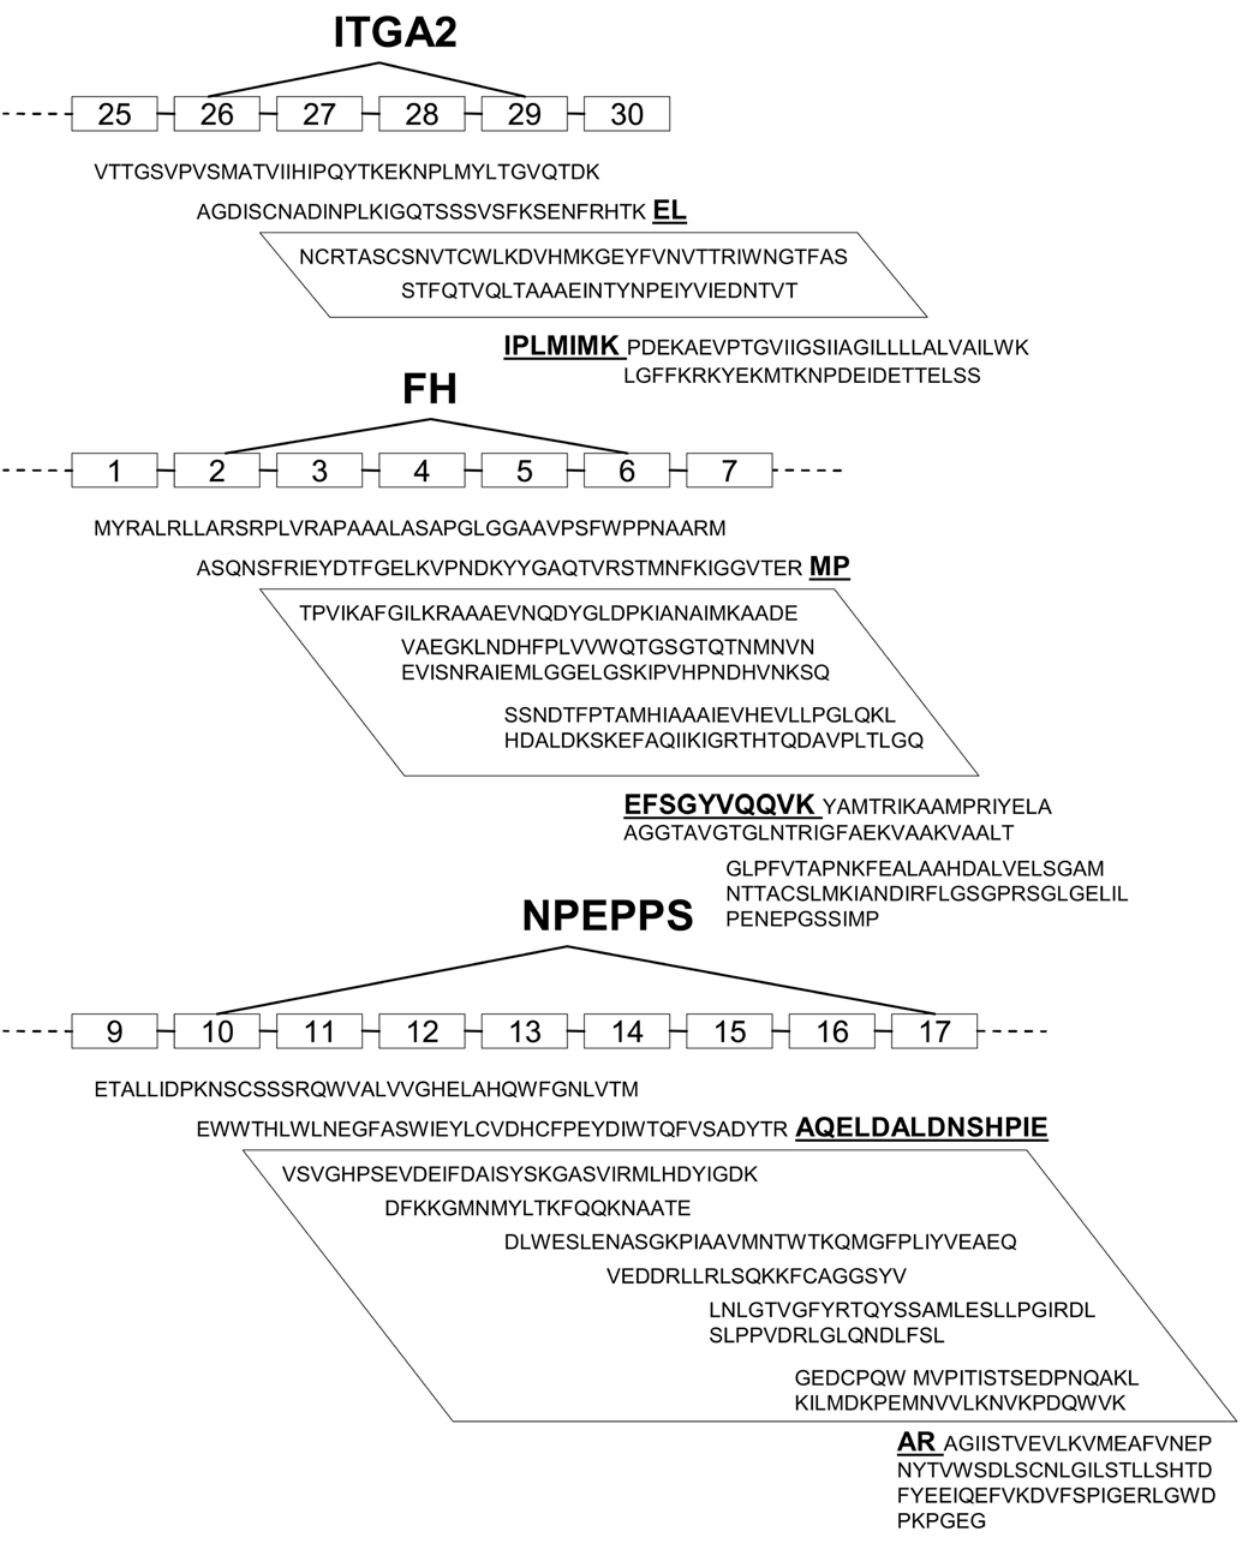
Figure 4. Exon skip events verified at mRNA level. Each numbered box represents an exon and the position in the gene. The skip event is indicated by the diagonal lines. The parallelograms enclose the portion of amino acid sequence that is absent from the novel splice isoform. The bold and underlined form the junction peptides.